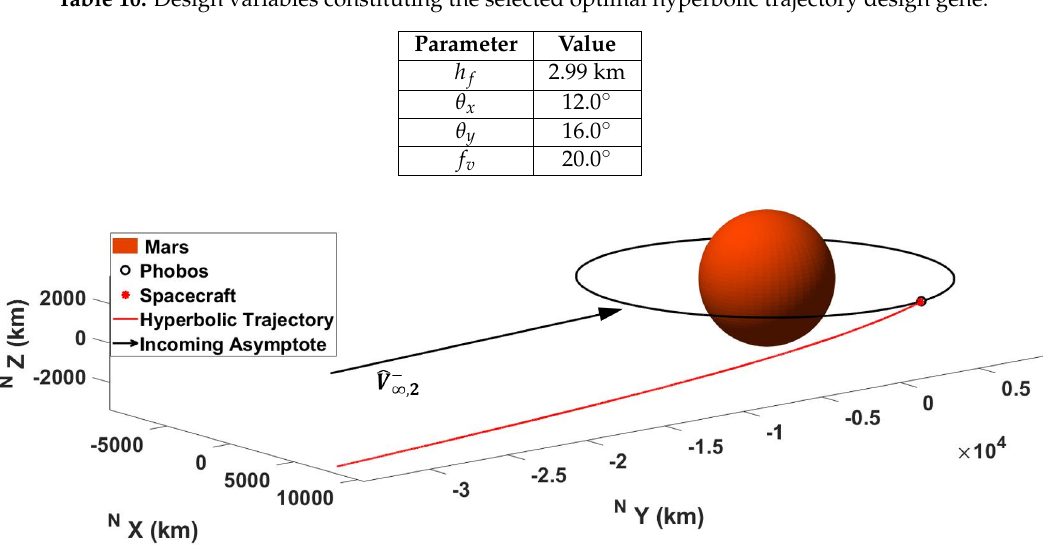
Table 10. Design variables constituting the selected optimal hyperbolic trajectory design gene.